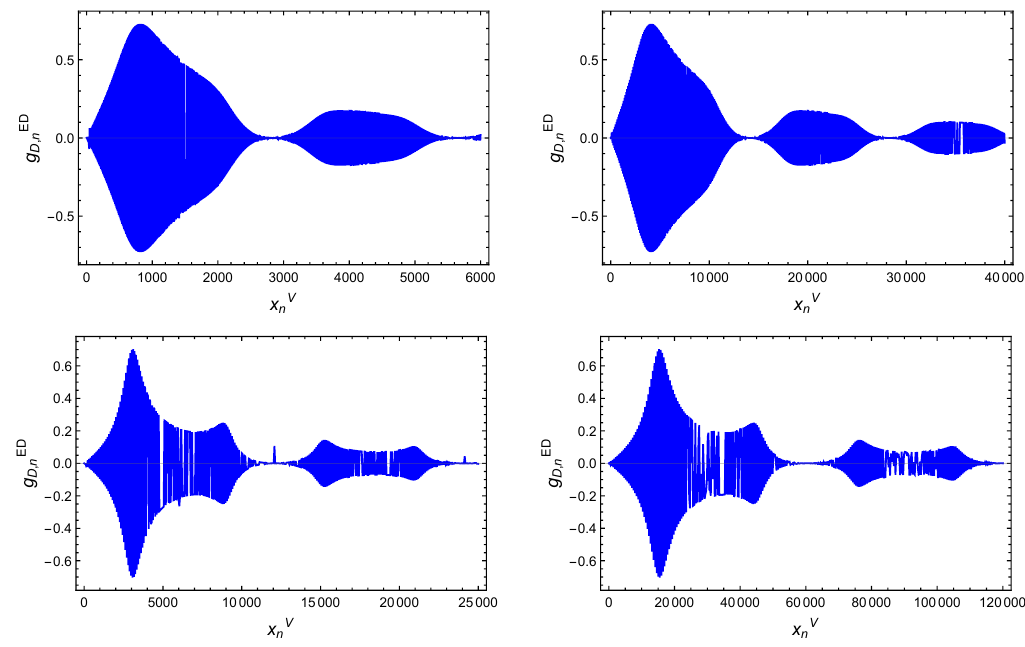
Figure 2 . Oscillatory behavior of the gauge KK couplings as a function of x V (cid:11) = 1 GeV and g D = 1 for purposes of demonstration, for BM I (top left), BM II (top left), BM III (bottom left) and BM IV (bottom